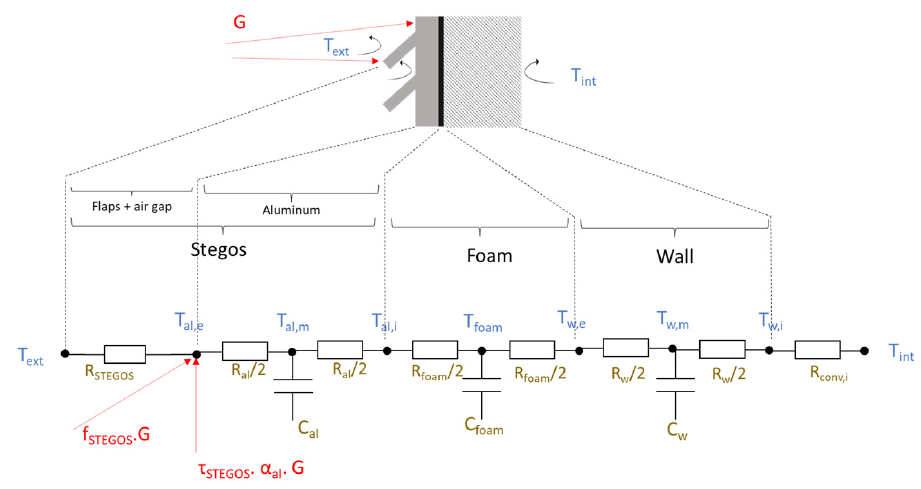
Figure 16. RC model of the wall assembly (case of ‘opaque wall’ configuration) with C i thermal capacities and R i thermal resistances of the nodes.